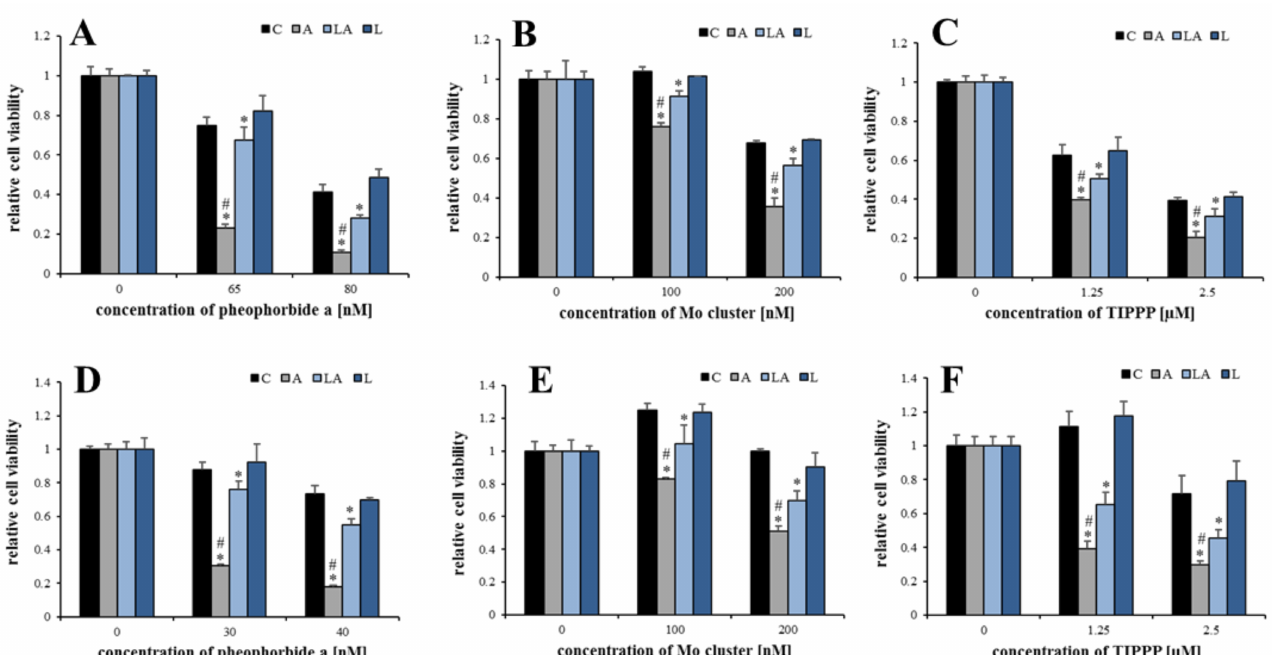
Figure A4. The effect of lactic acidosis on cancer cell sensitivity to photodynamic therapy. Viability of HeLa ( A–C ) and Hep G2 ( D–F ) cells cultured in experimental media for 72 h and then treated with photodynamic therapy using ( A , D ) pheophorbide a , ( B , E ) Mo cluster, and ( C , F ) 5,10,15,20-tetrakis(4-isopropylphosphinatophenyl)porphyrin (TIPPP). Viability was measured by resazurin assay. C, control; A, acidosis; LA, lactic acidosis; L, high lactate (* p < 0.05 compared to C, # p < 0.05 when comparing A and LA).